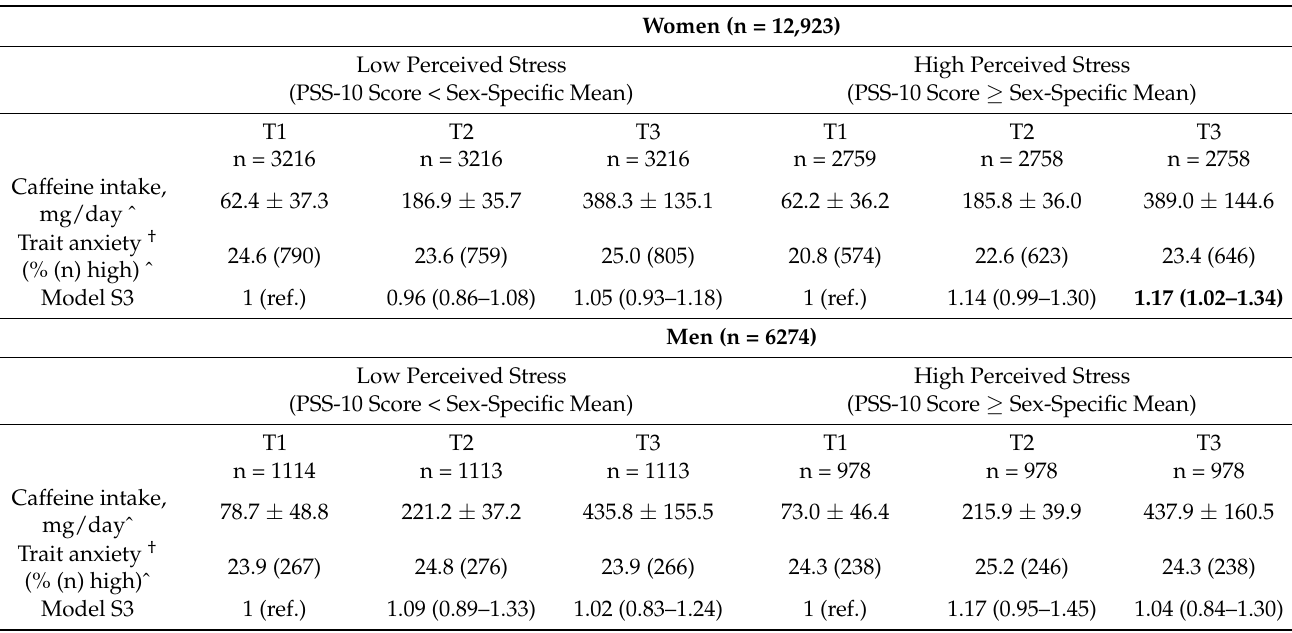
Table 4. Sensitivity analyses of the association (odds ratio, 95% CI) between tertiles of caffeine intake and odds of high trait anxiety according to perceived stress level in women and men from the NutriNet-Sant é cohort. Women (n = 12,923)